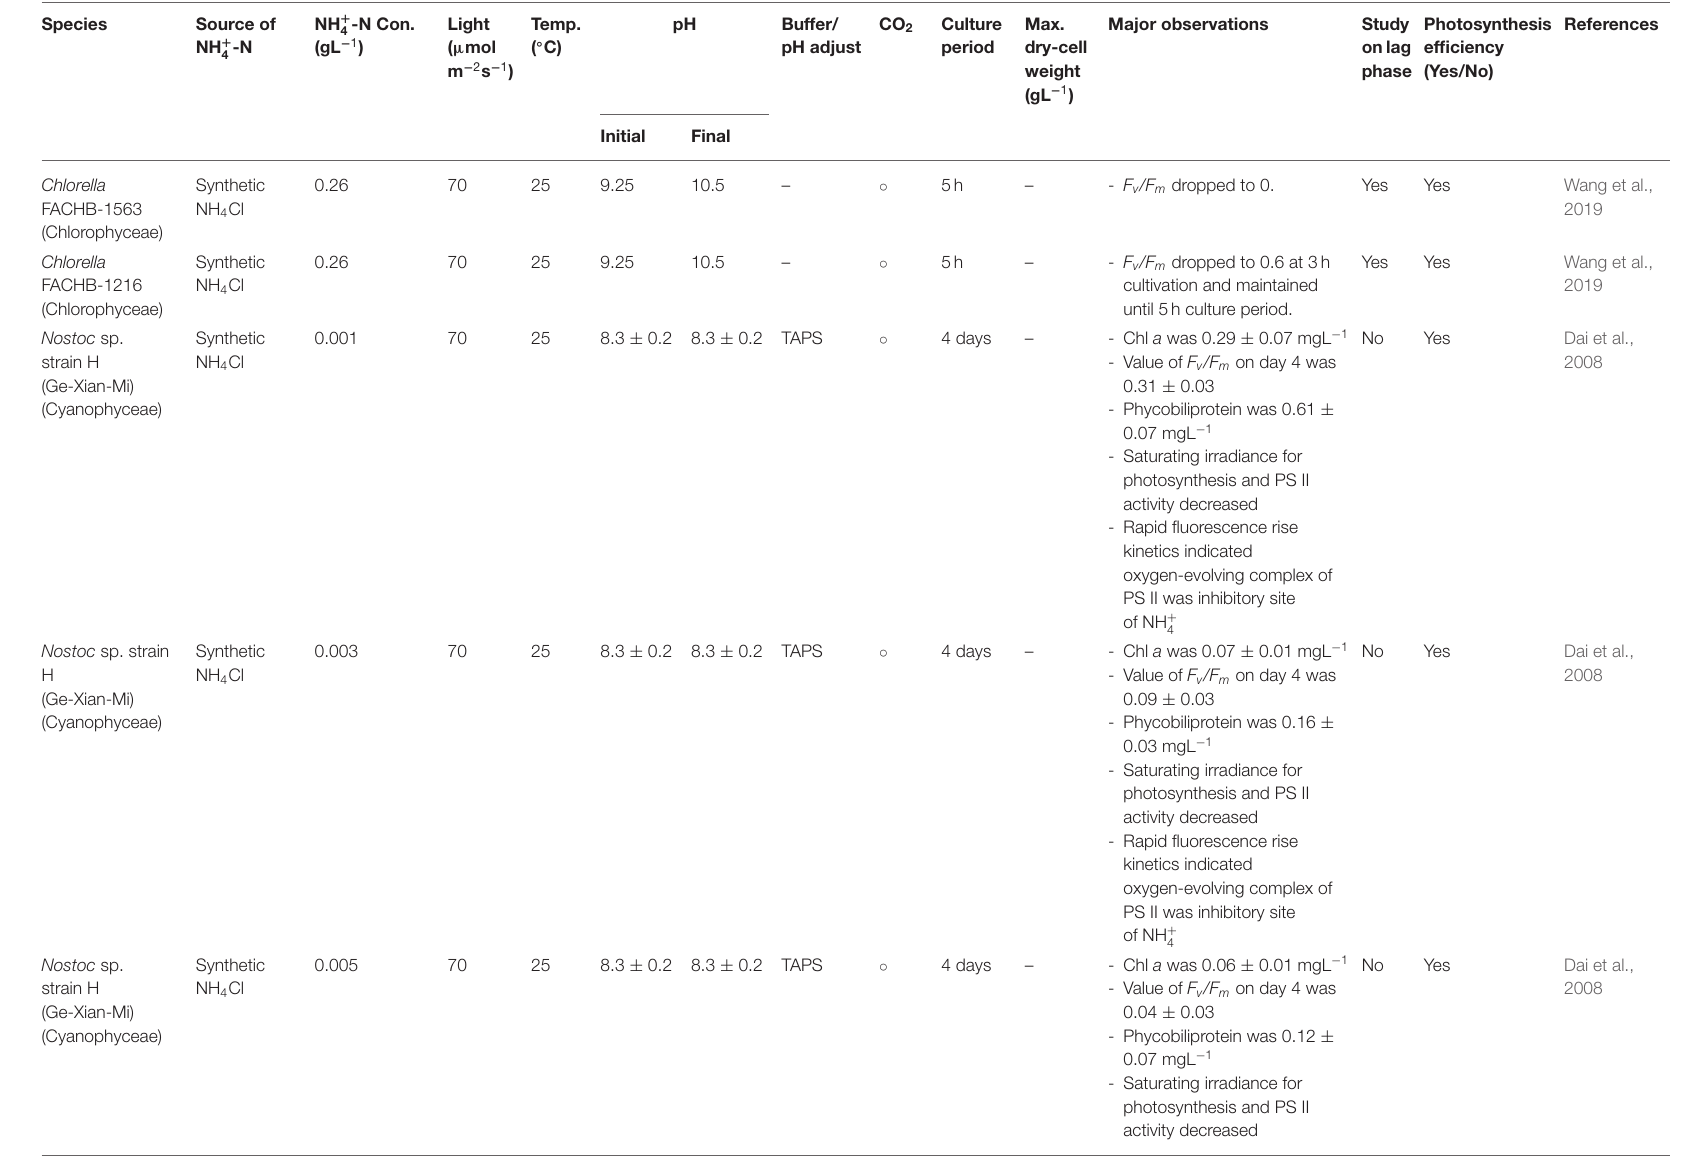
TABLE 1 | Evaluation of ammonium nitrogen activities from microalgae.